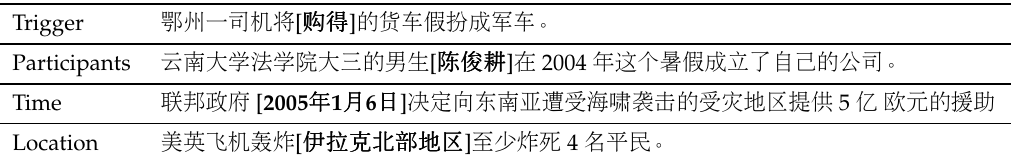
Table 1. An example of event